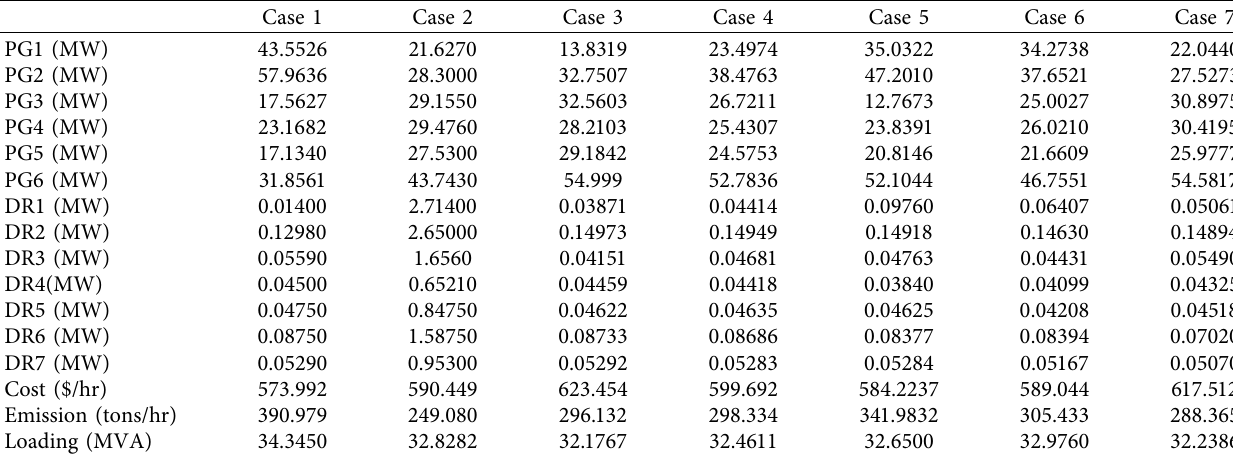
Table 6: Optimized variables for strategy A